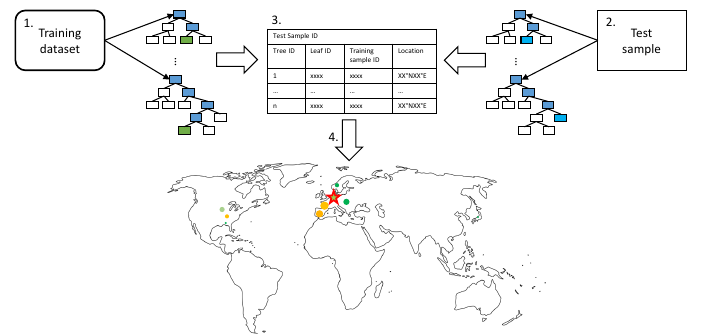
Figure 3. Leaf activation visualization pipeline as described in the text as enumerated bullet points. We match the training samples contributing to a specific test sample prediction and determine the influence each training sample has on the prediction. The basis set of training samples, the relative influence of a training sample, and the target test sample are visualized as a scatter plot on the map.